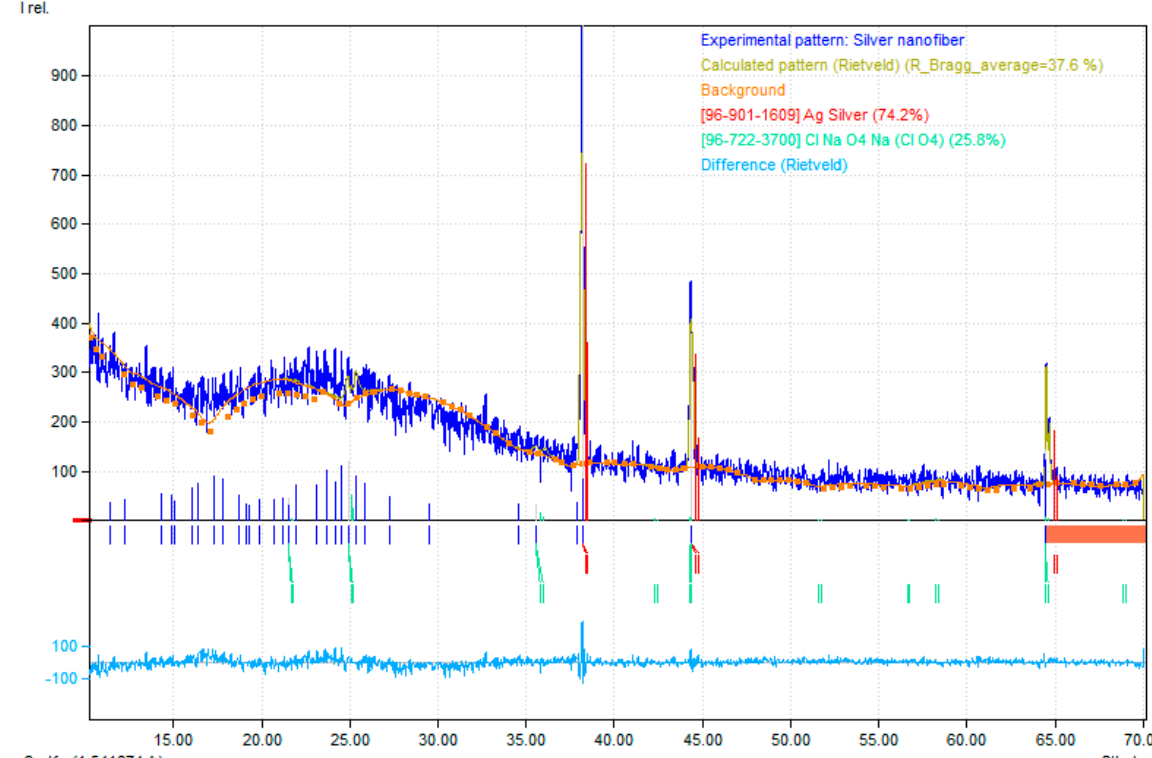
Figure 4. X-Ray Diffractionspectrumof Silver nanofibers. Figure 4. X-ray Diffractionspectrumof Silver nanofibers. Micromachines 2021 , 12 , x